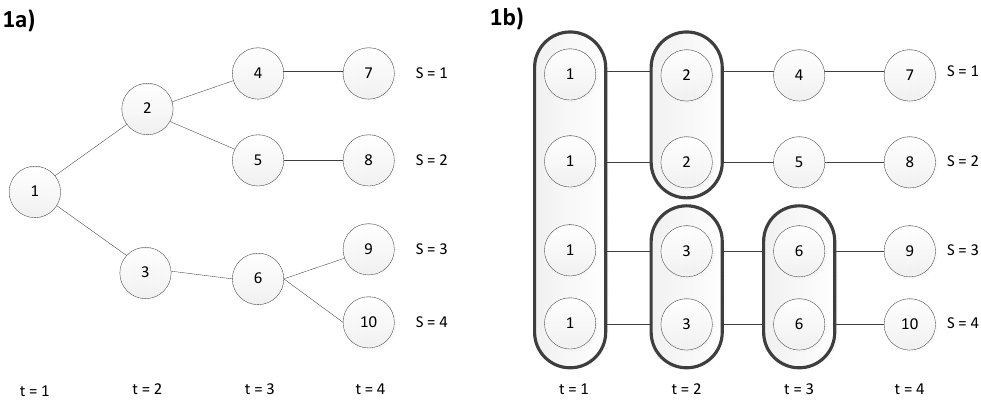
Figure 1. A scenario tree consisting of four scenarios and four stages (time periods) and 10 nodes ( 1a ) is shown. The scenarios are also shown in a disaggregated form ( 1b ); the non-anticipativity constraints (information sets Nt) are reflected by the balloons grouping the nodes. For example, in period two ( t = 2) node two shares scenarios one and two and therefore the decisions for this node (harvest or not harvest the stand) for scenarios one and two must be the